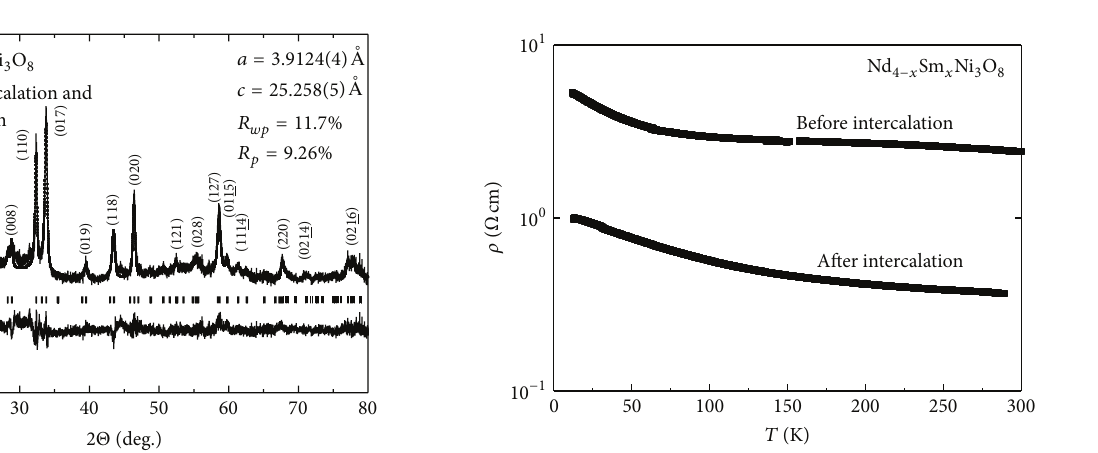
Figure2:XRDdataforsulfur-deintercalatedNd 3.5 Sm 0.5 Ni 3 O 8 .Tick marks and bottom solid line are Bragg positions and difference between calculated and observed data, respectively.